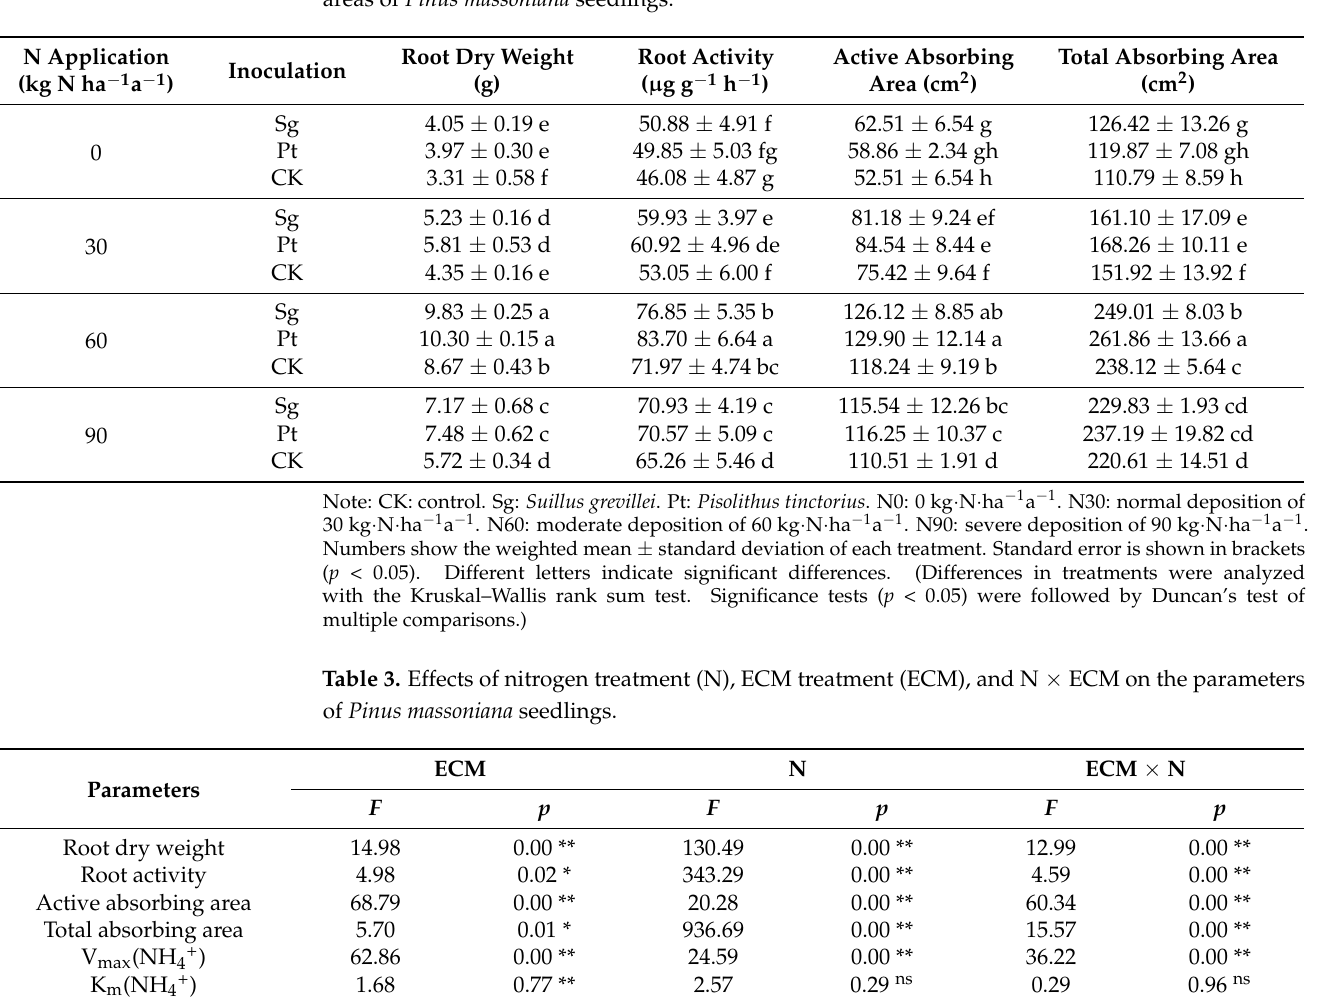
Table 2. Effects of nitrogen application and inoculating ectomycorrhizal fungi on root absorbing areas of Pinus massoniana seedlings.